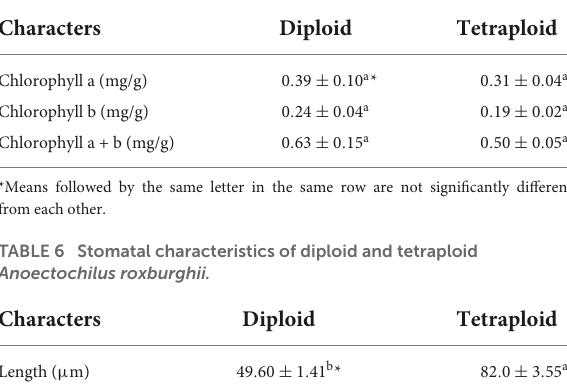
TABLE 5 Content of photosynthetic pigments in diploid and tetraploid Anoectochilus roxburghii.